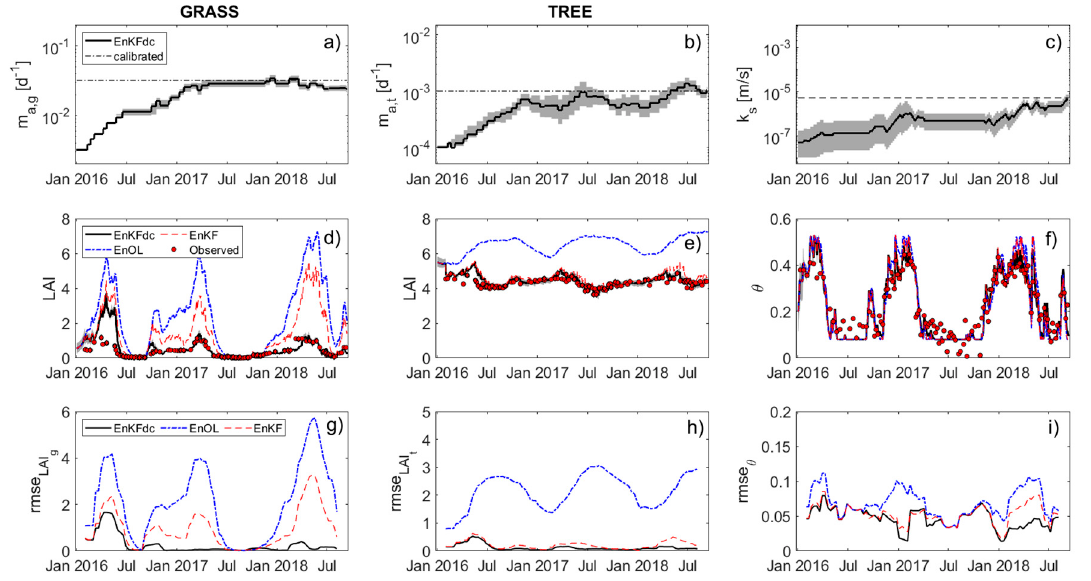
Figure 4. Same as Figure 3 but for initial low ˆ k s , ˆ m a , g (for grass), and ˆ m a , t (for trees) values of 5 × 10 − 8 m/s, 0.0032 d − 1 , and 0.0001 d − 1 ,